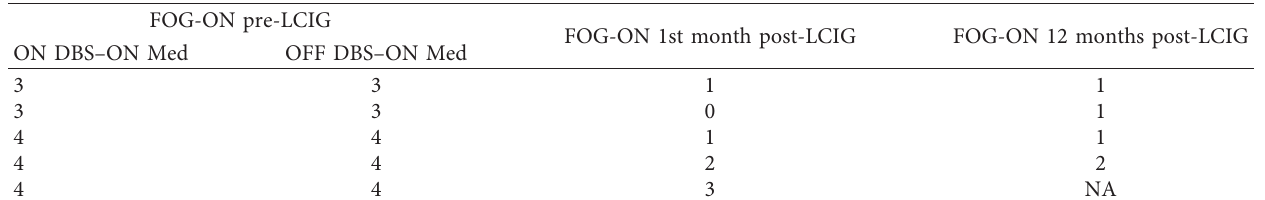
Table 3: Changes in FOG-ON based on item 14 in the UPDRS scale in the different scenarios.